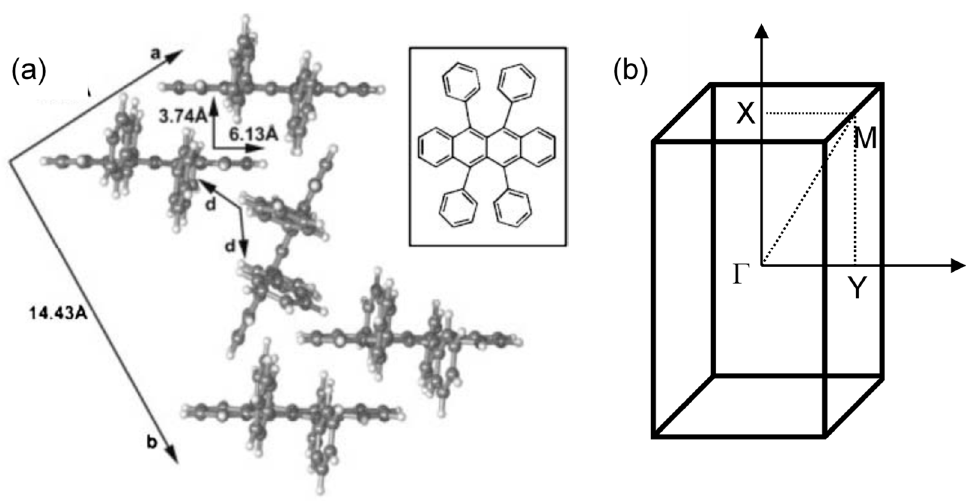
Figure 5. ( a ) Illustration of the lattice parameters within the a-b plane of rubrene single crystal. The molecular structure of rubrene is also shown in the inset. ( b ) The reciprocal lattice of crystalline rubrene. Γ X , Γ Y and Γ M correspond to the a, b and the diagonal crystalline direction, respectively. From Ref. [68] with permission.